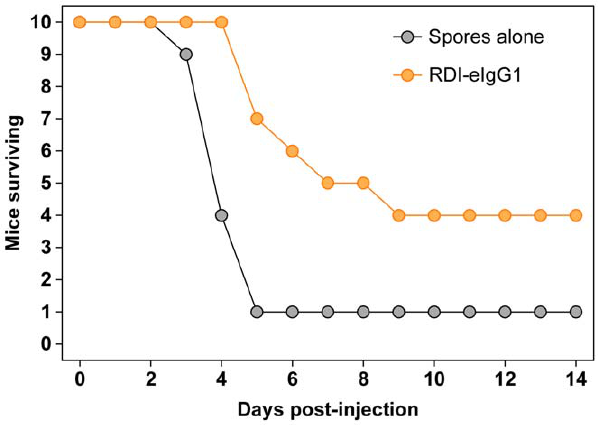
Figure 3. RDI-eIgG1 protects rats from LeTx challenge in the short term but shows delayed toxicity. Male 200 gram HSD rats (5/ group) were co-injected i.v. with LeTx (40 m g PA + 12 m g LF) and RDI (19 m g) or RDI-eIgG1 (49 m g). Rats were monitored and time of death recorded.